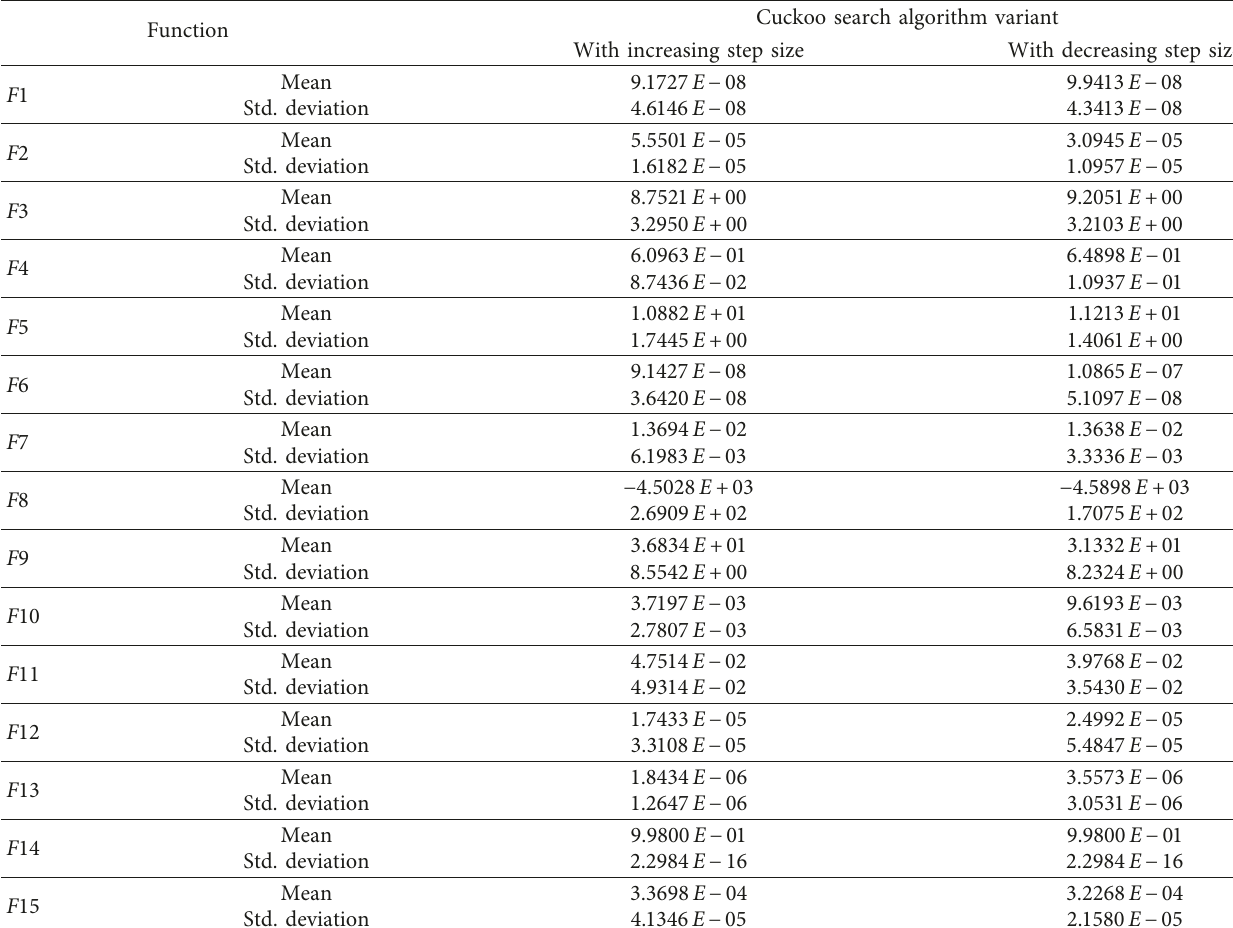
Table 4: Optimization results for ablation